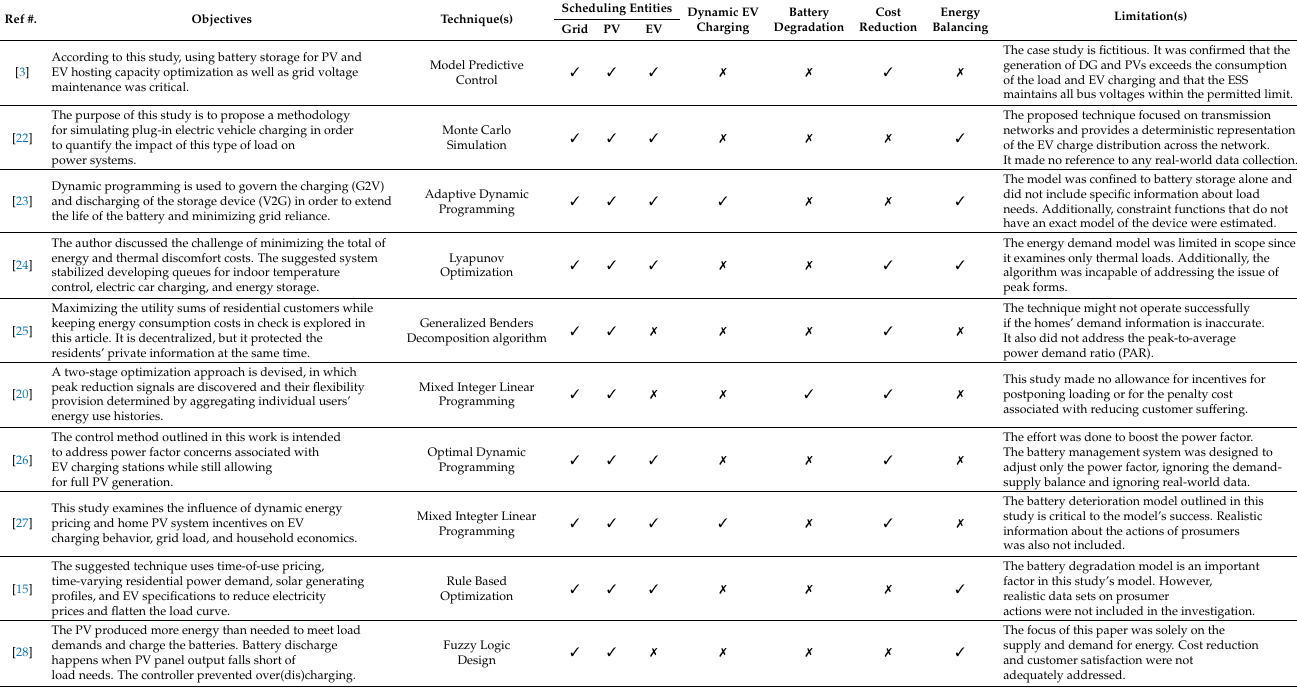
Table 1. Objectives, limitations, and critical analysis of the past literature.